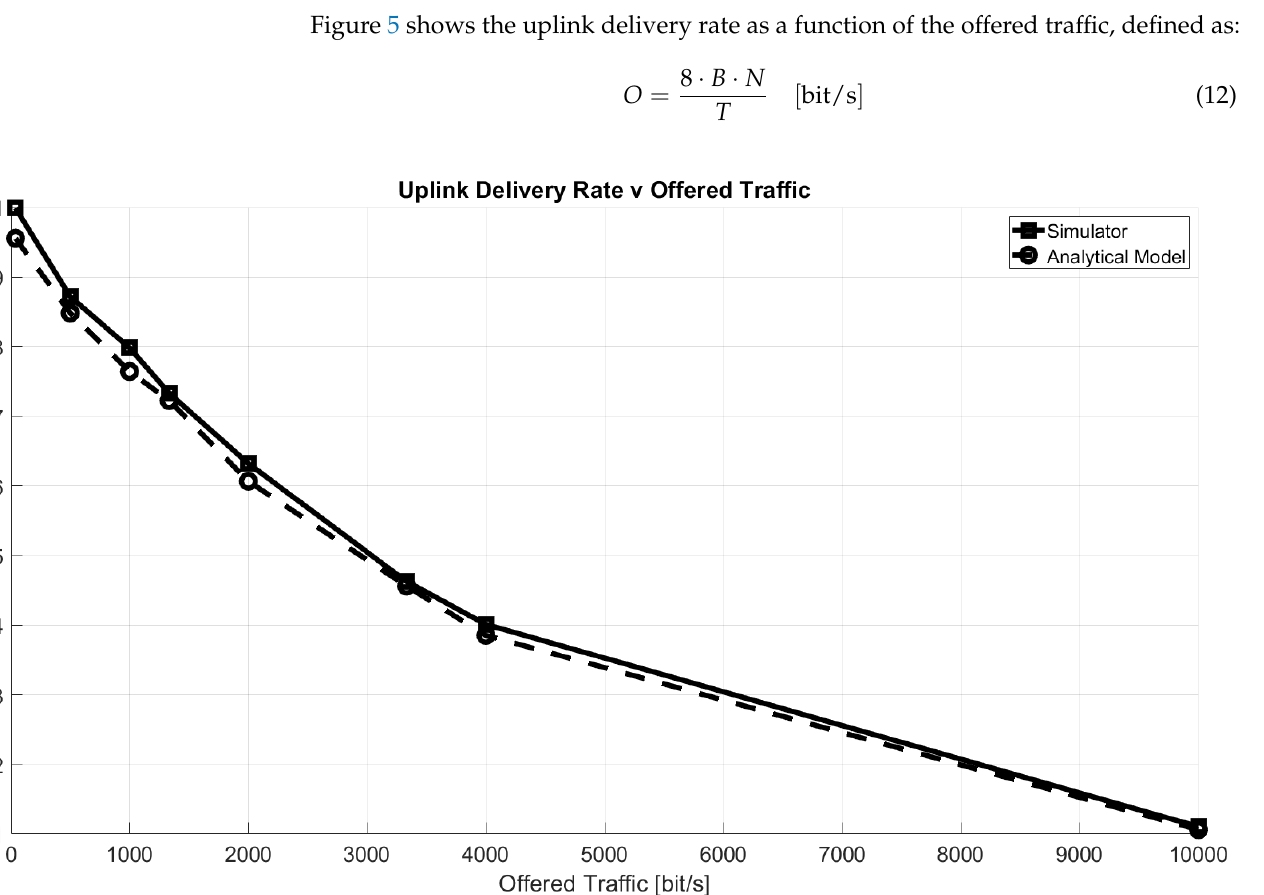
Figure 5. Uplink delivery rate as a function of offered traffic,